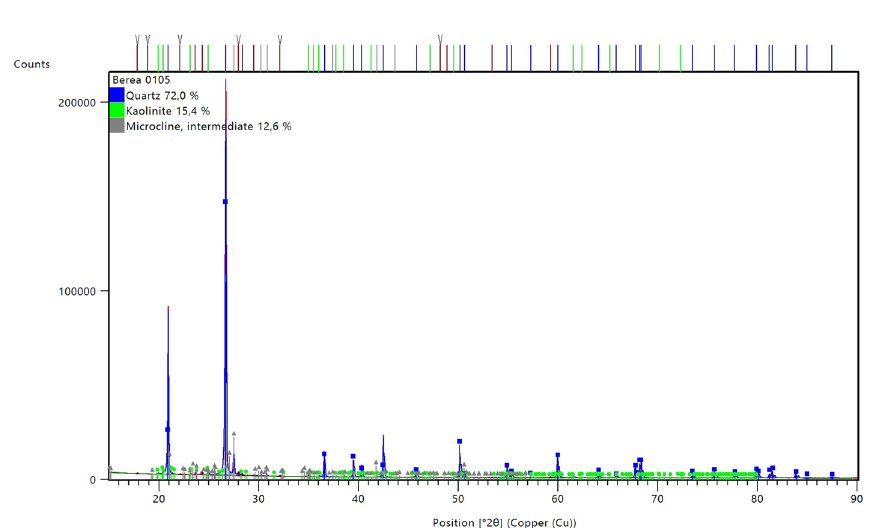
Fig. 2 The results of X-ray powder diffraction (XRD) analysis of Berea sandstone material. Blue line: quartz, red: kaolinite, and green: